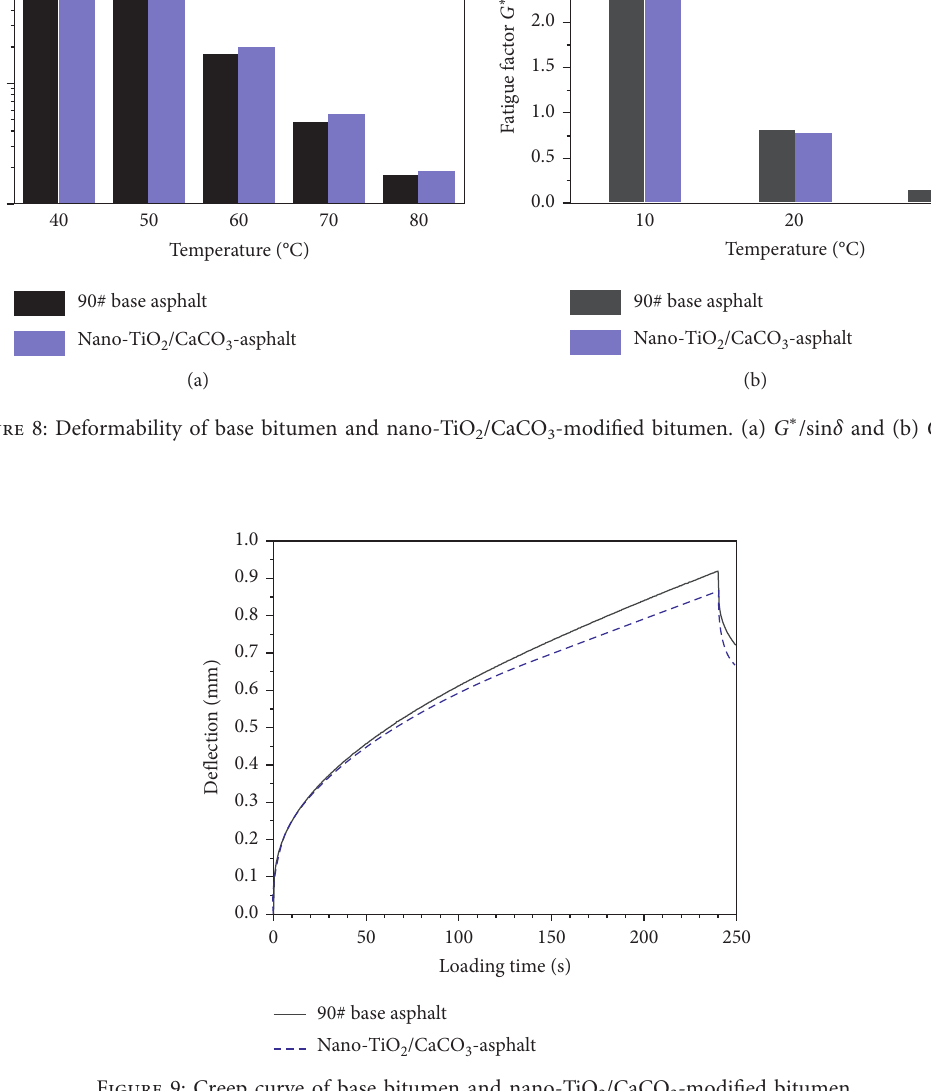
2 /CaCO 3 -modified